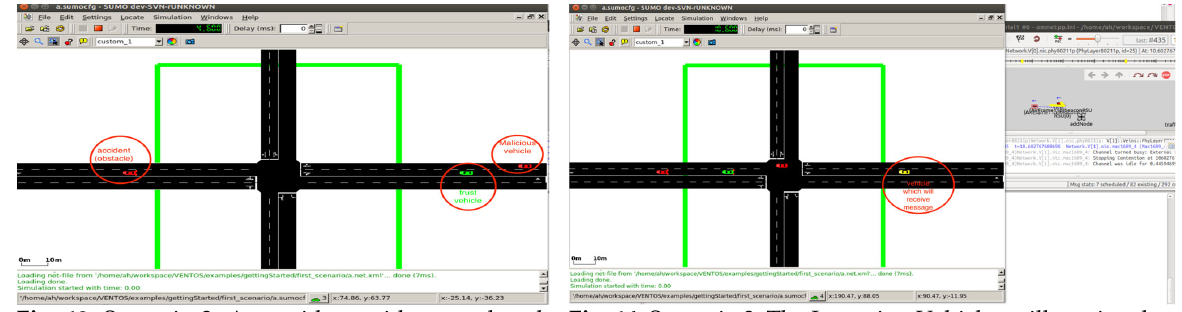
Fig. 13. Scenario 3: An accident with trusted and untrusted vehicles scenario